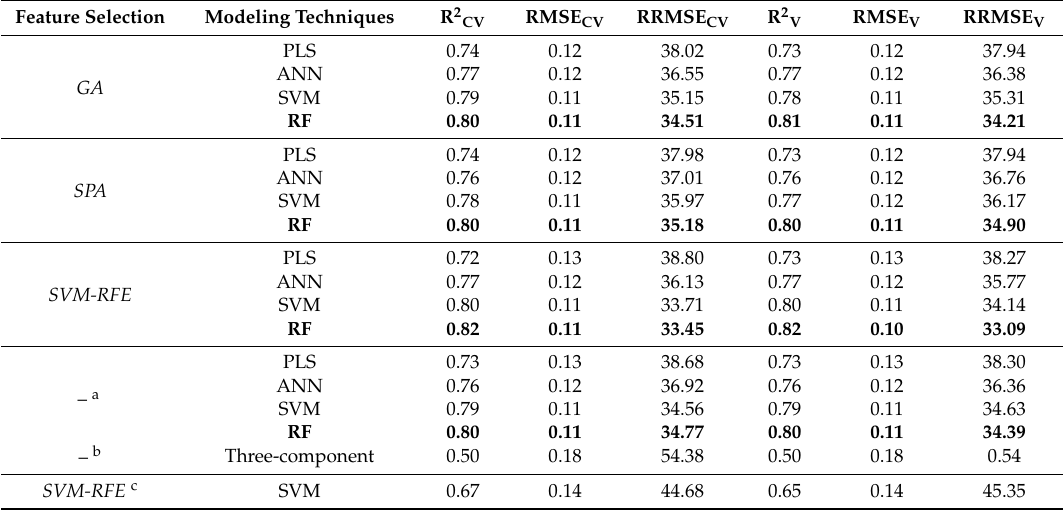
Table 6. Model performances of cross validation (CV) and independent validation (V) for picoplankton size fractions obtained by different combinations of feature selection and modelling techniques. Feature selection techniques included genetic algorithm (GA), successive projection algorithm (SPA) and recursive feature elimination based on support vector machine regression (SVM-RFE). The modeling techniques included partial least square (PLS) regression, artificial neural network (ANN), support vector machine (SVM), and random forests